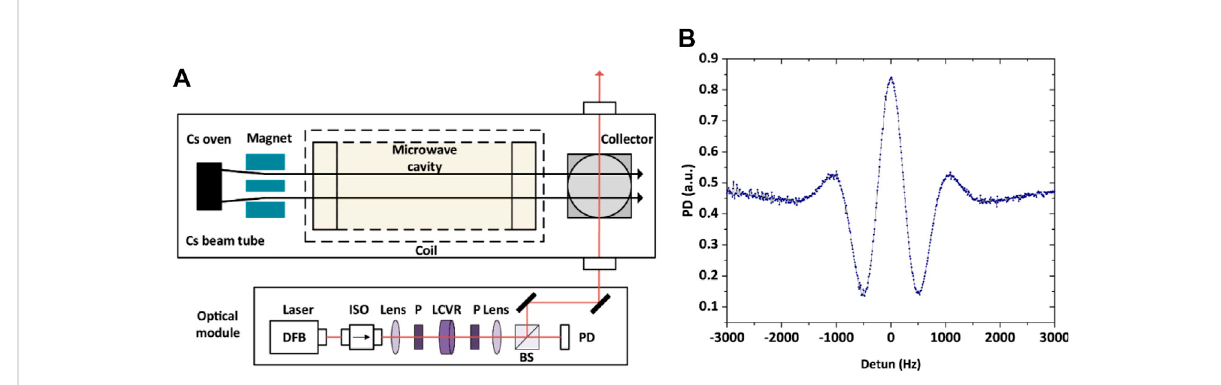
FIGURE 4 (A) Con fi gurationofOMCC.ISO,isolator;P,polarizer;lens,convexlens;BS,beamsplitter;PD,photodiode;LCVR,liquidcrystalvariableretarder. (B) Ramsey fringe.